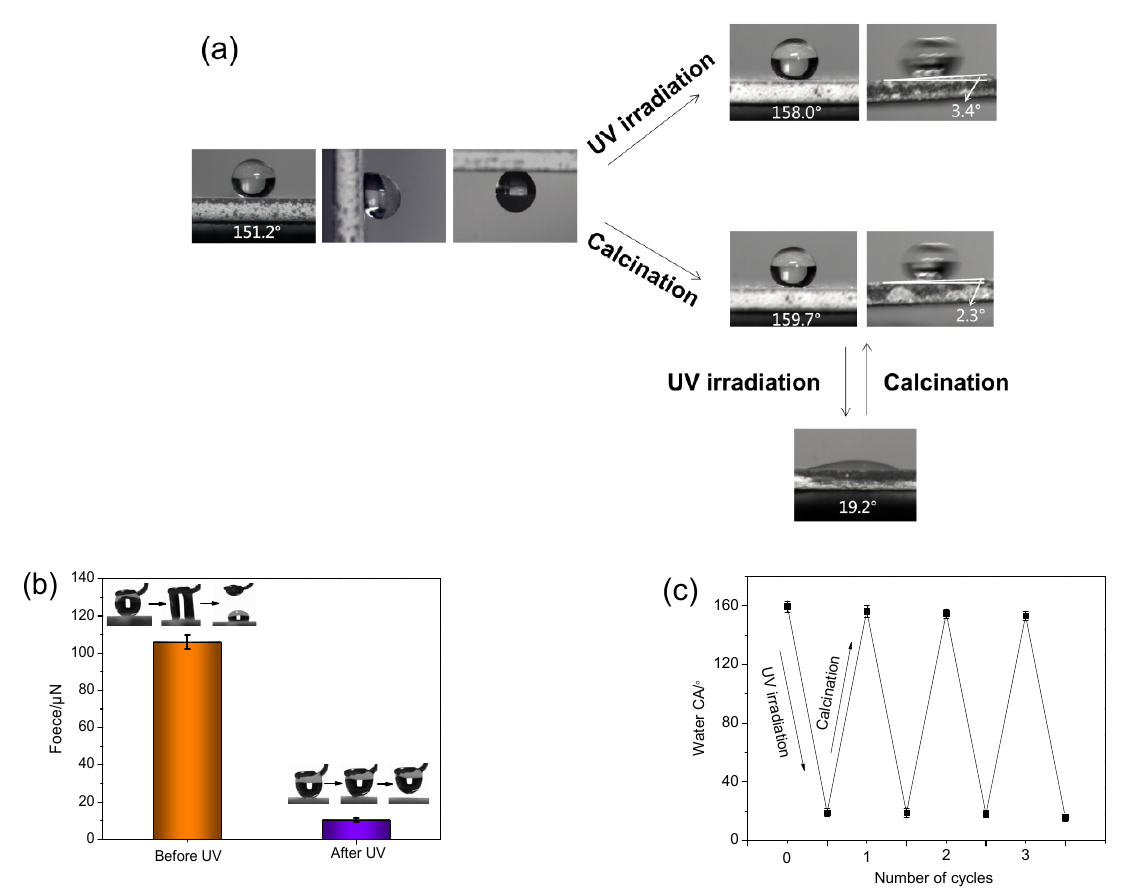
Figure 2. ( a ) The changes in the coating’s wettability and adhesion to water droplets before and after UV irradiation and calcination. ( b ) The adhesion force of the coating to a water droplet before and after UV irradiation. ( c ) The changes in WCAs of the coating after alternate UV irradiation and calcination.